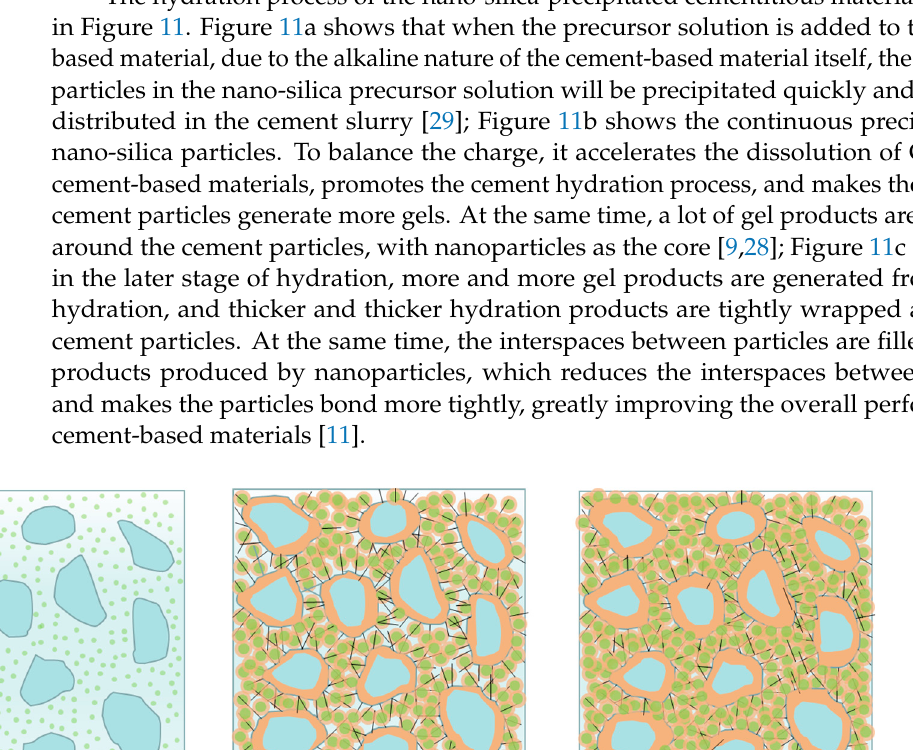
Figure 10. Hydration process of pure cement ‐ based materials.